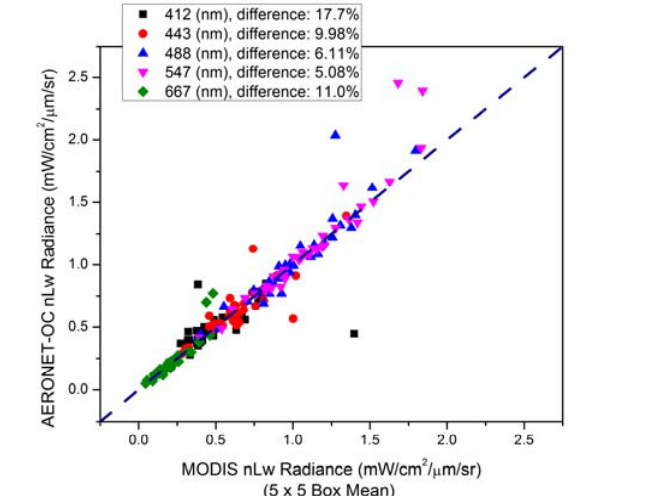
Figure 7. AERONET-OC vs. MODIS-retrieved MODIS retrievals based on optimal aerosol model selection from the set of 10 possible aerosol models (representing size fraction) after the relative humidity has already been determined from climatology.